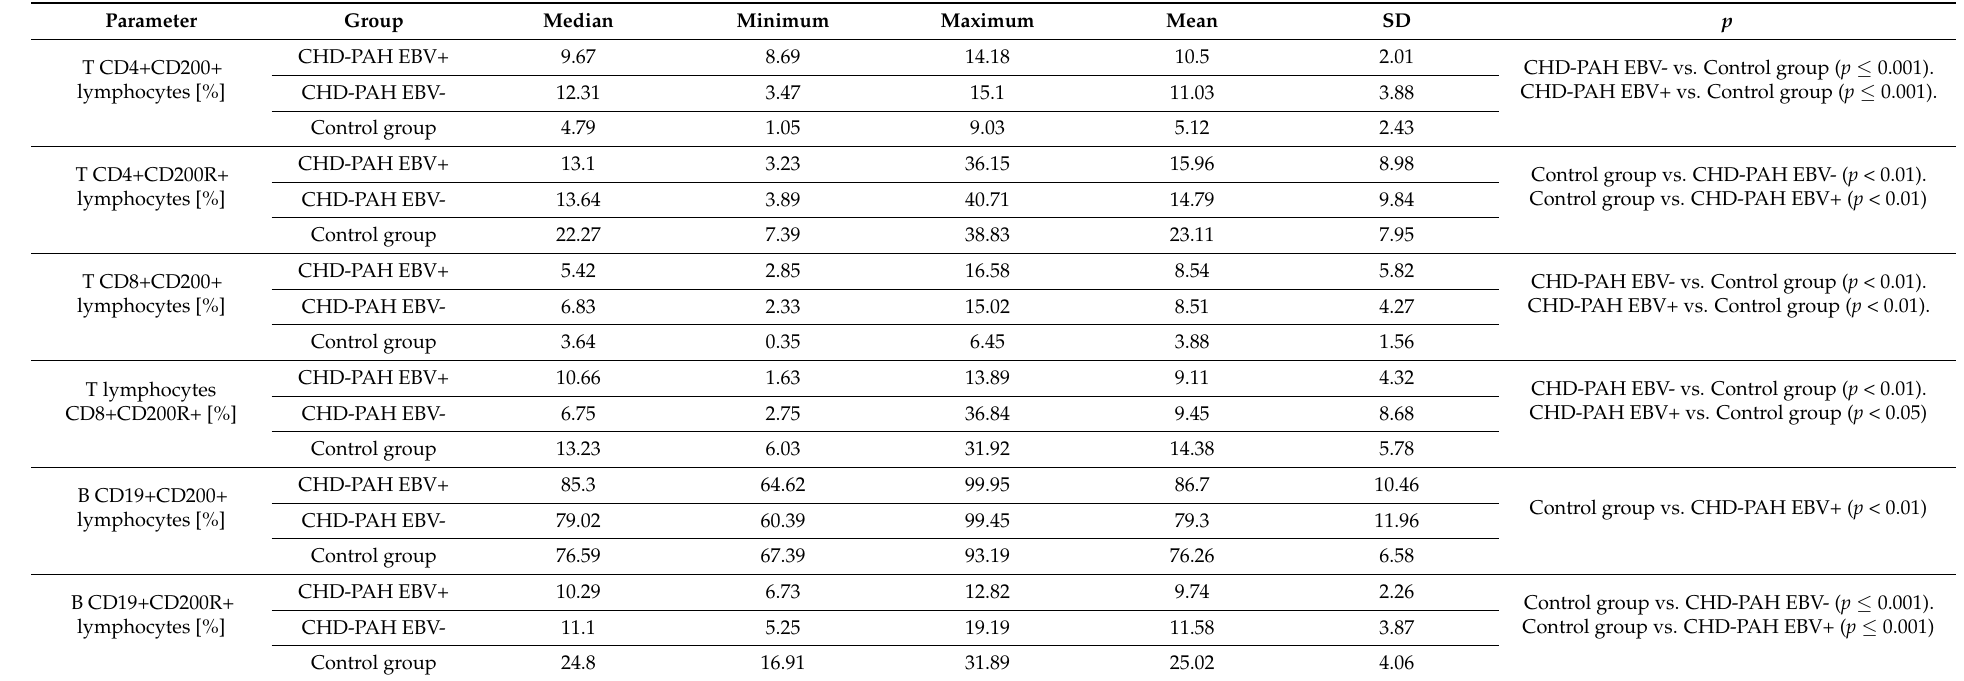
Table 5. Percentage of lymphocytes expressing CD200 and CD200R molecules in patients with CHD-PAH divided into EBV (+) and EBV (-) groups.